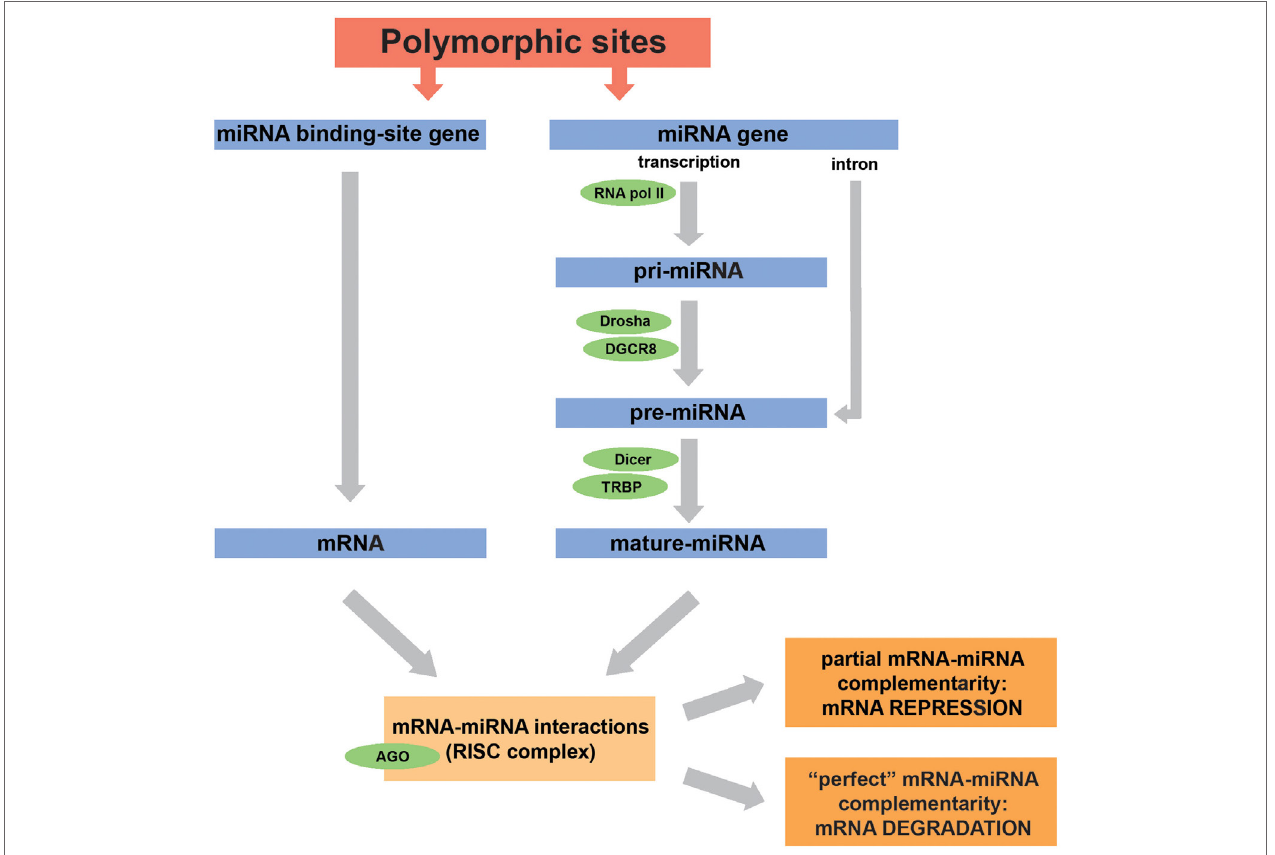
FiGURe 1 | Biogenesis and action of microRNAs (miRNAs) are affected by genetic variations. miRNA biogenesis is mediated by a number of enzymes and co-factors. Some of the most important enzymes for each miRNA processing step are indicated in green. Depending on the degree of miRNA-mRNA complementarity, mRNA expression will be repressed or the molecule will be directed to degradation. Genes encoding miRNAs or miRNA-binding sites can host polymorphisms that modify the action of these molecules. For example, polymorphisms in miRNA genes can downregulate miRNA expression, and polymorphisms in miRNA-binding sites can disrupt the miRNA–mRNA interaction. Furthermore, the effects of genetic variations in miRNA-machinery genes also have an important impact on the biogenesis of miRNAs. This figure was mainly based on the following references: Drury et al. (10), Lorio et al. (21), Ryan et al. (22), Ryan et al. (23), and Rupaimoole and Slack